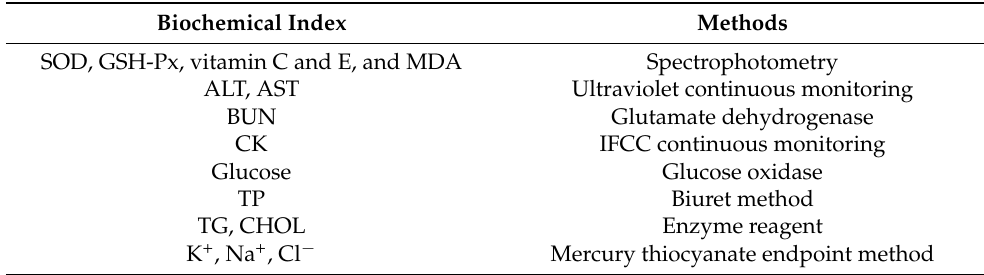
Table 2. The detection methods of serum parameters of goats. Biochemical Index